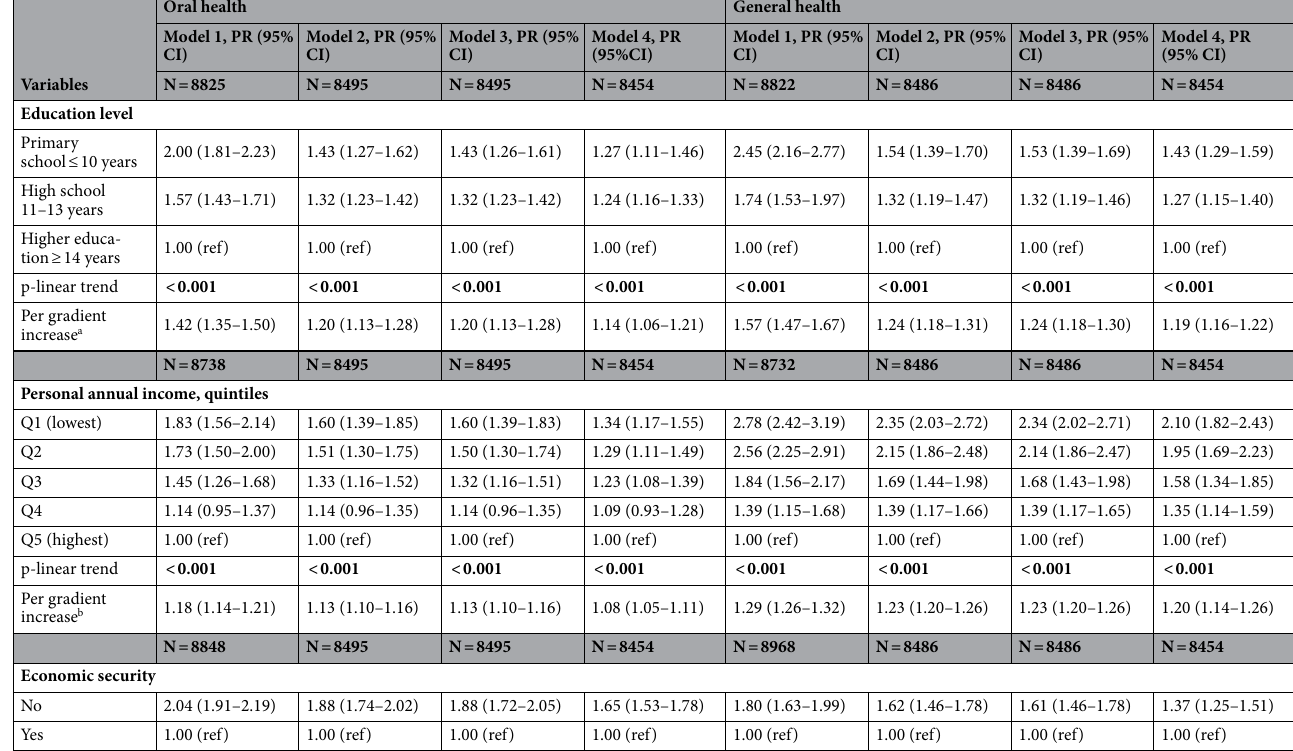
Table 3. Prevalence Ratio of socioeconomic determinants in relation to self-reported oral and general health. Model 1 was unadjusted. Model 2 was adjusted for age (four categories), sex, marital status (single, cohabitant/ married) and mutually adjusted for education, income, economic security. Model 3 includes variables in Model 2 plus centrality (in four categories). Model 4 includes variables in Model 3 and was mutually adjusted for self- reported oral health status and general health status. a PR for per gradient increase in education. b PR for per gradient increase in income. Significant values are in